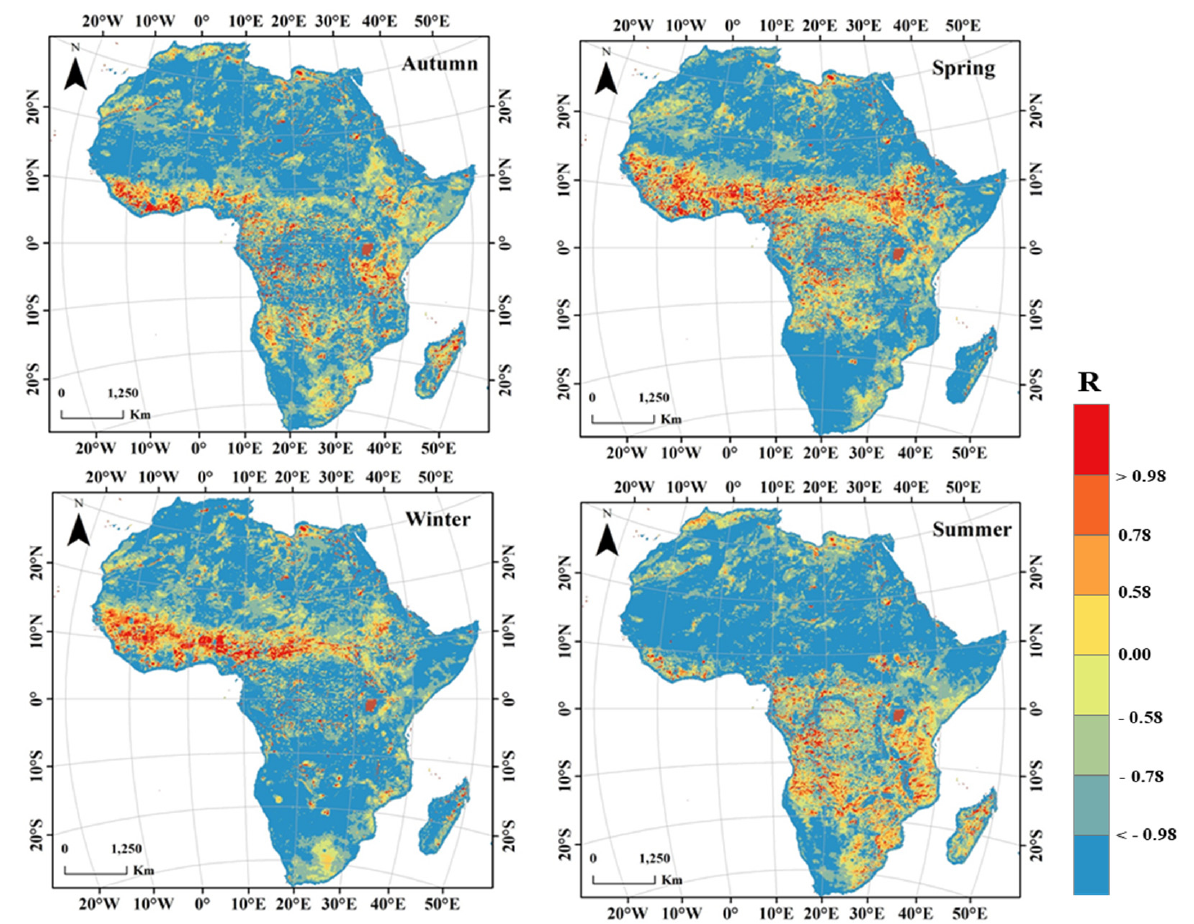
Figure 8. The correlation coefficient of seasonal soil moisture change from 2003 to 2017.